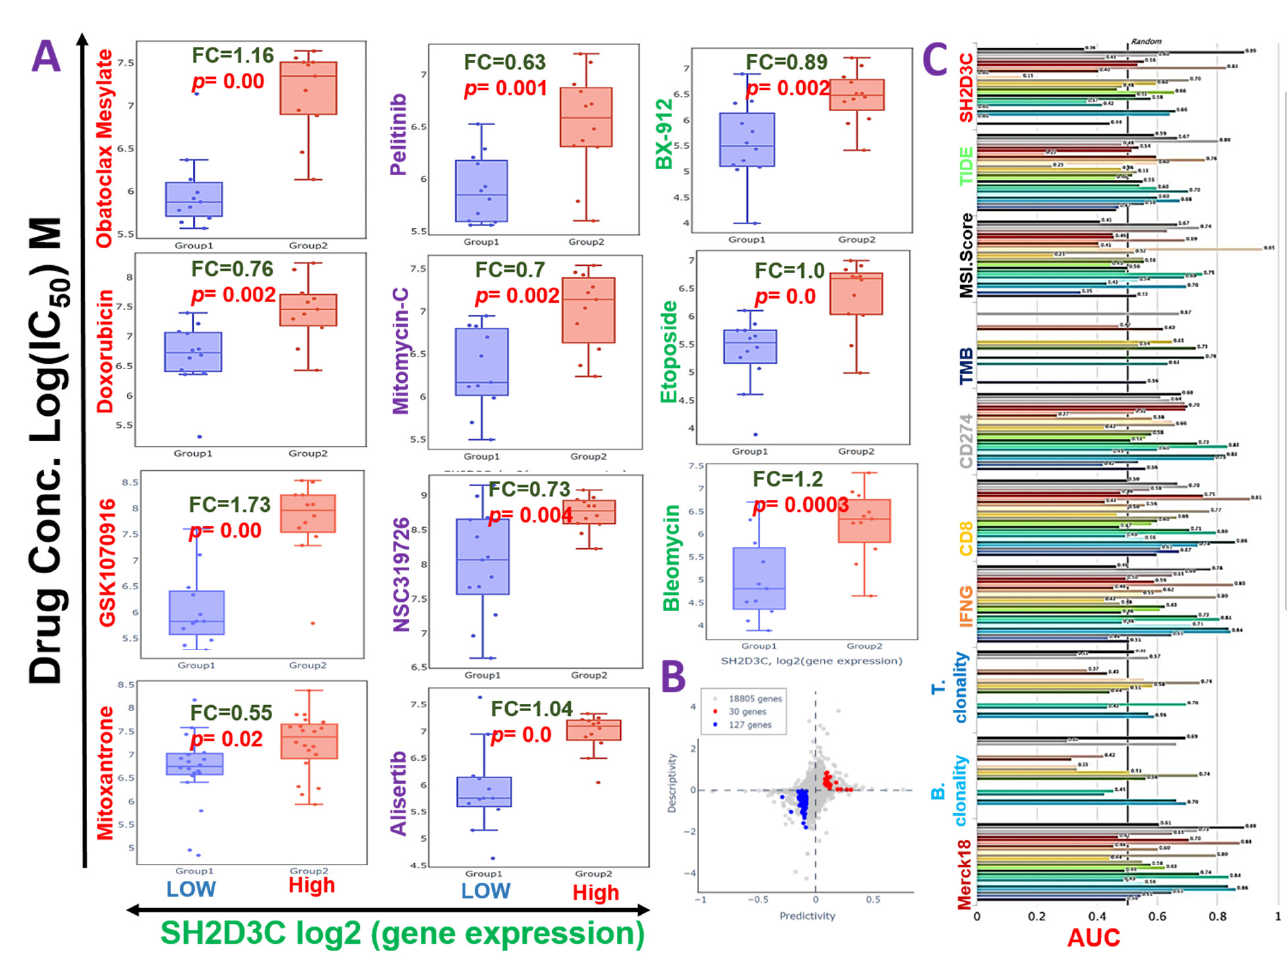
Figure 6. Non-structural protein 3 ( NSP3; SH2D3C ) is associated with chemotherapy resistance in NSCLC. ( A ) Bar plots showing the sensitivity of various clinical drugs between samples with low and high expression levels of SH2D3C . ( B ) Scatter plot of the efficacy of SH2D3 knockdown ( shSH2D3C ) in association with the expression of a number gene. The predictivity is defined as the fold change (FC) of shSH2D3C efficacy between samples of high and low expression of the gene. Descriptivity is defined as the FC of gene expression between samples of high and low shSH2D3C efficacy. ( C ) Bar plot of the comparative biomarker relevance between the SH2D3C and standardized biomarkers.